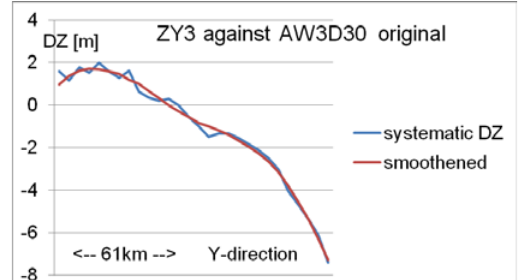
Figure 12. Systematic height errors in Y-direction, Saintes- Maxime, ZY3 DSM against AW3D30 DSM